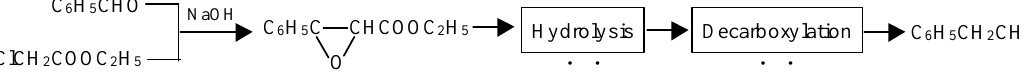
FIGURE 1 . A schematic drawing of the traditional chemical production process for phenylacetaldehyde; “ ·· ”marks the points of waste discharge. electrosynthesis of phenylacetaldehyde, electrolysis of Mn(II) to Mn(III), an oxidation of phenylethane to phenylacetaldehyde should be carried out in the same H this paper, the optimum condition of Mn(III) oxidizing phenylethane has been studied and the improvement of the current efficiency of electrolytic production of Mn(III) in the same H concentration has also been